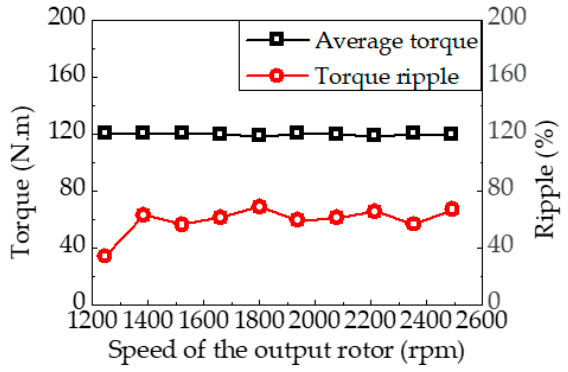
Figure 11. Torque characteristics with the variation of the speed of the output rotor in region II.